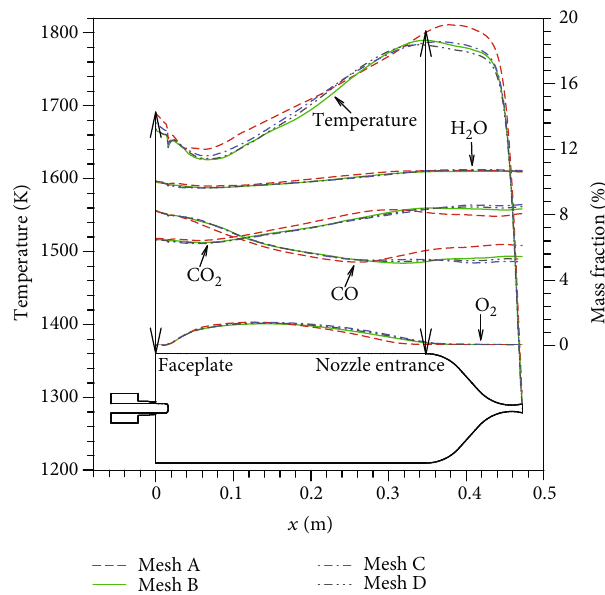
, CO, CO , and H O) versus the 2 2 2